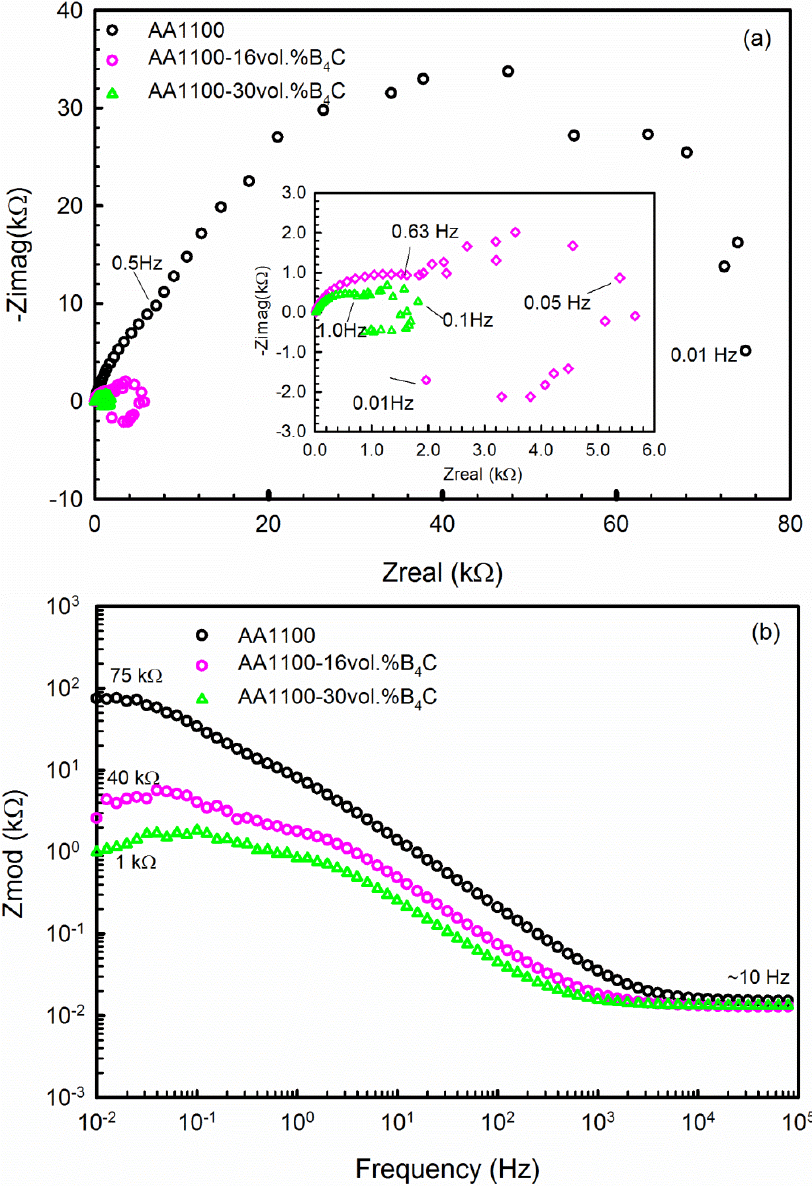
Figure 5. ( a ) Nyquist and ( b ) Bode plot of AA1100, AA1100-16 vol.% B 4 C and AA1100-30 vol.% B 4 C obtained after 1 h immersion in 3.5 wt.% NaCl solution.